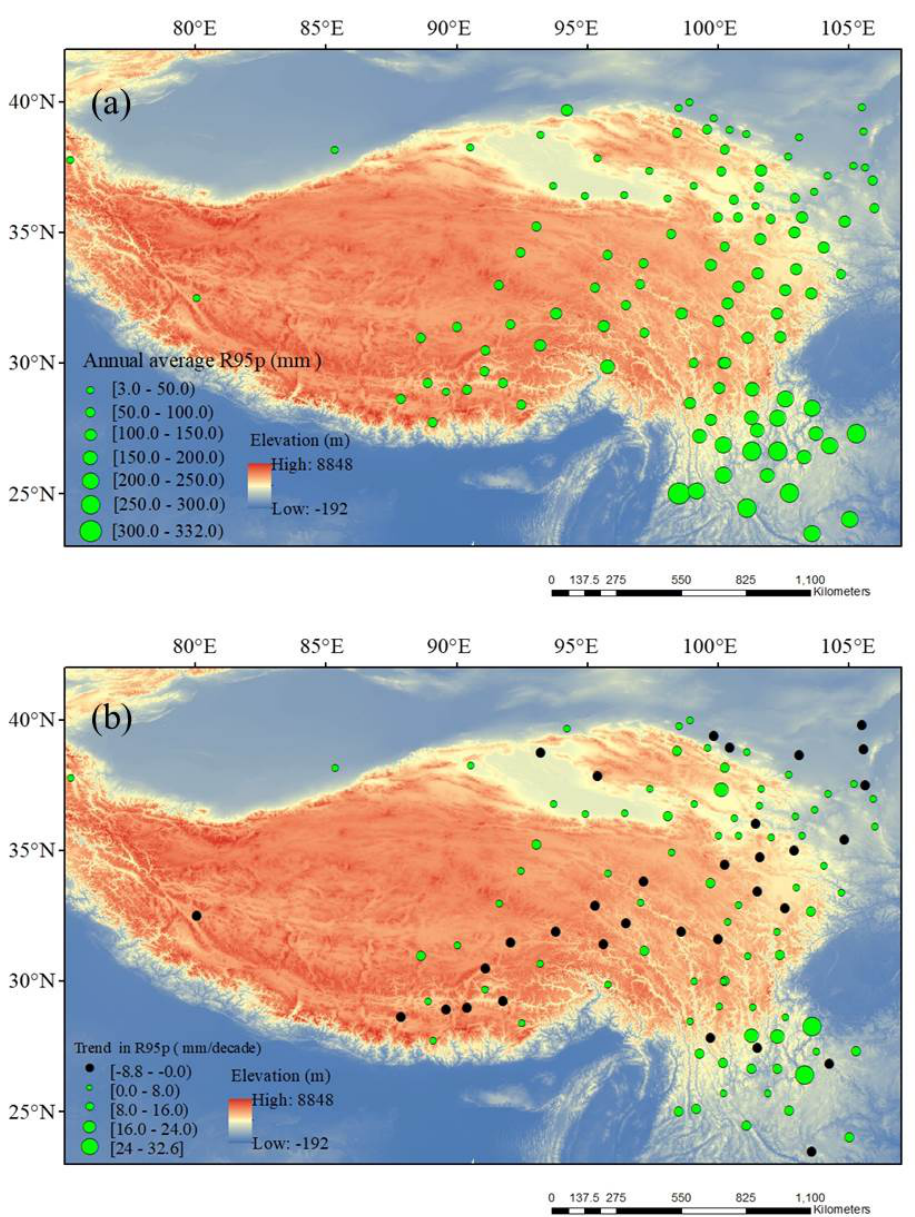
Figure 5. Spatial distributions of the averaged extreme precipitation (R95p) ( a ) and long-term climatological trends in annual average extreme precipitation (R95p) ( b ) in the TP and TPS during 1971–2017. (35 stations passed the 95% significance test in ( b )).